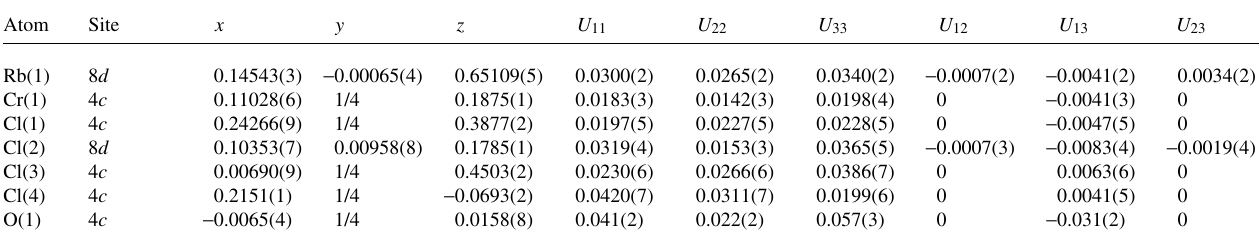
Table 3. Atomic coordinates and displacement parameters (in Å 2 )